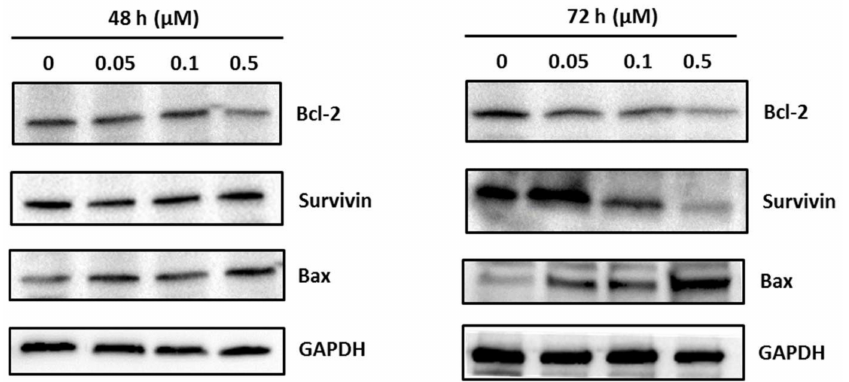
Figure 6. β -Lactam 33 decreases the expression of anti-apoptotic proteins Bcl-2 and survivin and increases the expression of pro-apoptotic protein Bax in MCF-7 cells. MCF-7 cells were treated with vehicle control (ethanol 0.1% v / v ) or 21 at the indicated concentrations (0.05, 0.1 or 0.5 µ M) for 48 h ( left ) or 72 h ( right ). Then, the cells were harvested for Western blot analysis to detect the level of the apoptosis-related proteins. Results are indicative of three separate experiments, performed independently. To confirm equal protein loading, each membrane was stripped and re-probed with GAPDH antibody.